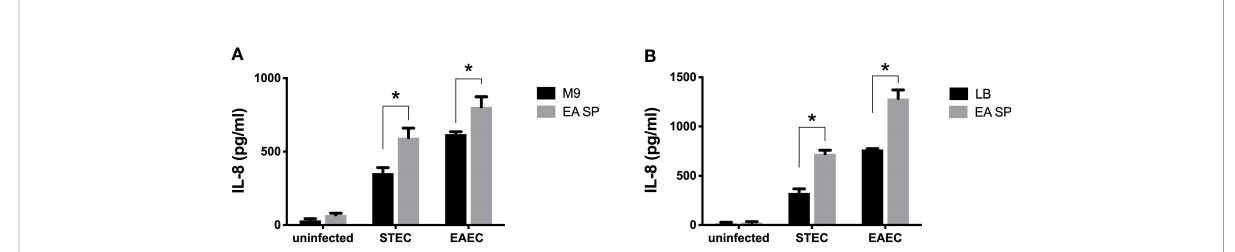
FIGURE 3 Induction of IL-8 secretion by DEC pathotypes in the presence of EA SP. T84 cells were infected with STEC or EAEC in the presence of the supernatant obtained from the overnight growth of E . albertii (EA SP) in M9 (A) or LB medium (B) . As a negative control, we used uninfected cells incubated with EA SP or with the medium used to prepare the supernatant. Three hours post-infection, the level of IL-8 secretion was evaluated by ELISA. Graphed data are the mean of one representative experiment performed in triplicate, with the error bars indicating standard deviation. * p < 0.05 by ANOVA and multiple comparison analysis.